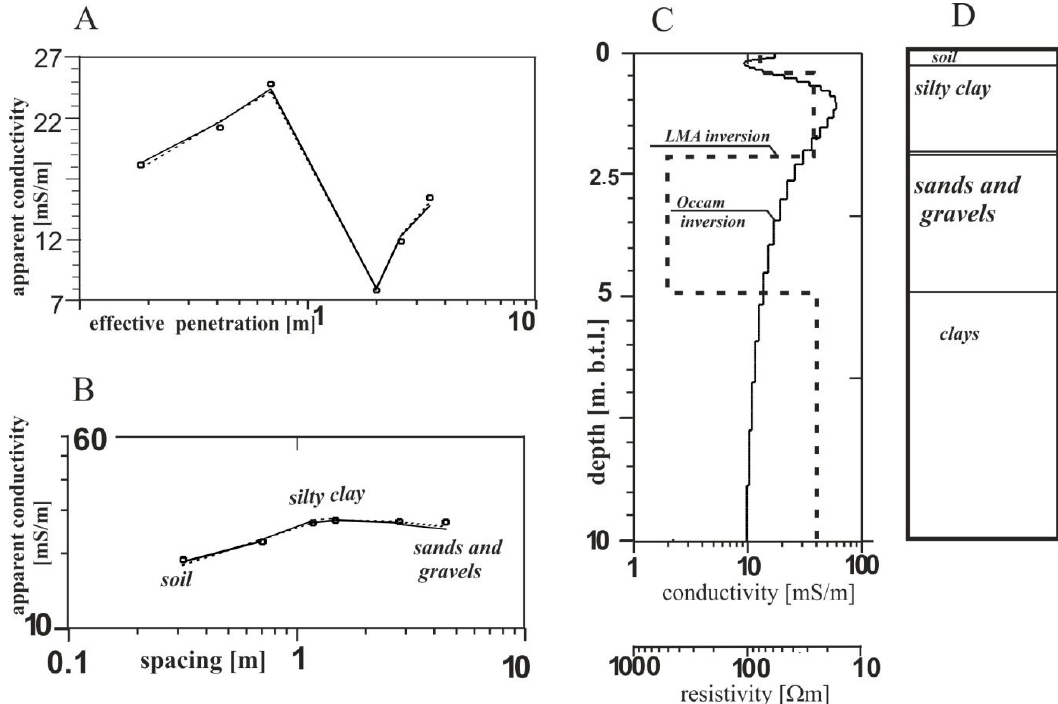
Figure 3. Results of an interpretation of GCM sounding No. 1 (Figure 1) with 1D LMA (layered model) and 1D Occam (smoothest model) algorithms; A —matching the calculated data to the measured data using IX1D software; B —fitting between the calculated data and measured data using Convert software; C —the resulting geoelectric models; D —borehole data.